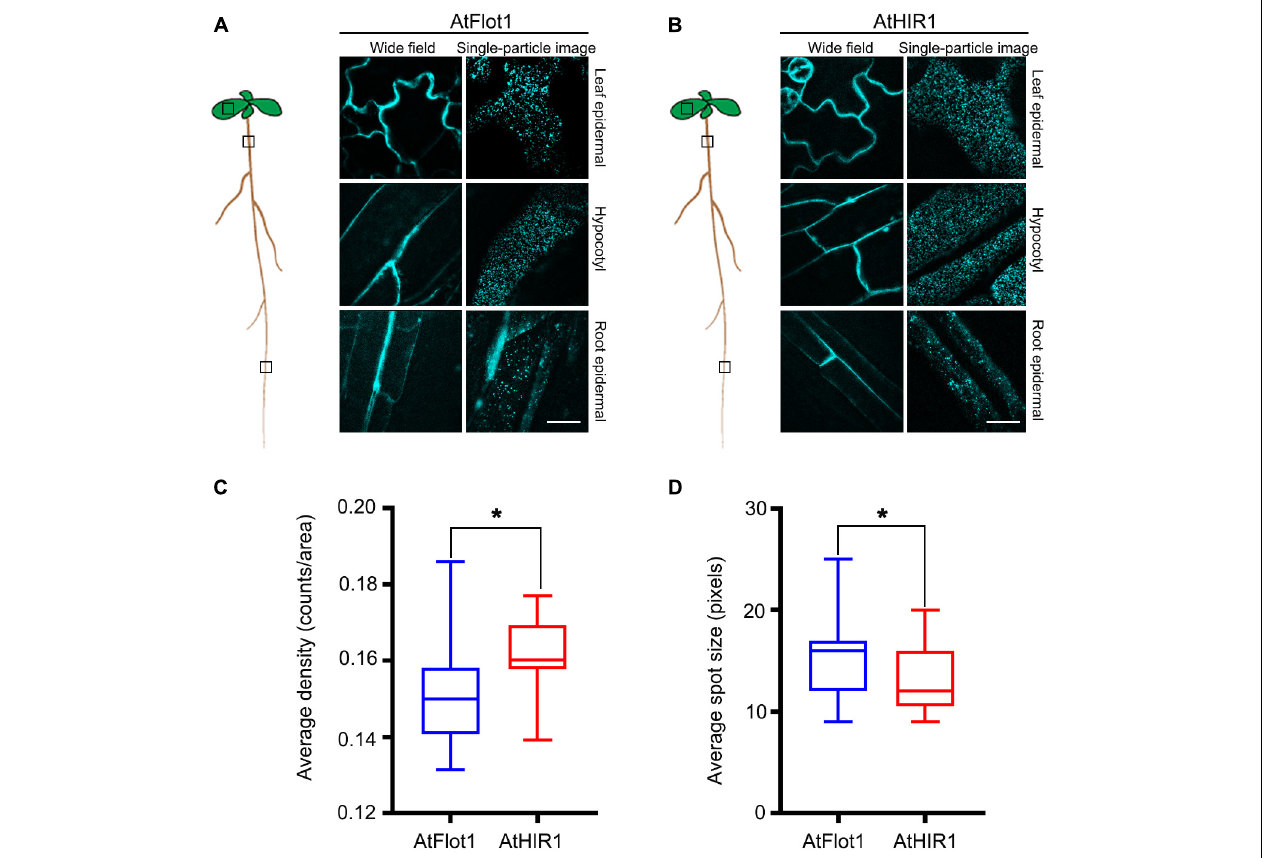
FIGURE 1 | AtFlot1 and AtHIR1 label a variety of distinct membrane domains in epidermal cells of Arabidopsis. (A,B) Upper planes of leaf epidermal cells (top panels), elongating hypocotyl cells (middle panels), and root epidermal cells (bottom panels) were imaged in 5-d-old seedlings of Arabidopsis plants expressing GFP-AtFlot1 (A) and AtHIR1-GFP (B) . Bar = 5 µ m. (C) Average fluorescence density of GFP-AtFlot1 and AtHIR1-GFP fluorescent spots. For each examination, at least 50 cells from each of five seedlings were examined. In each case, three biological replicates were performed. Statistical significance was determined